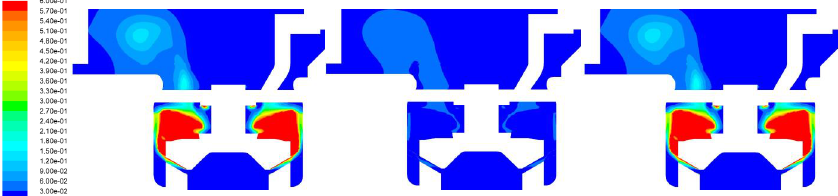
Figure 12. Case 2 (1.5 ppm air mass fraction) at 120° of crank rotation . (left) total second phase volume fraction. (middle) air volume fraction. (right) vapour volume fraction. Figure 12: Case 2 (1.5 ppm air mass fraction) at 120 ∘ of crank rotation: (left) total second phase volume fraction; (middle) air volume frac- tion; (right) vapour volume